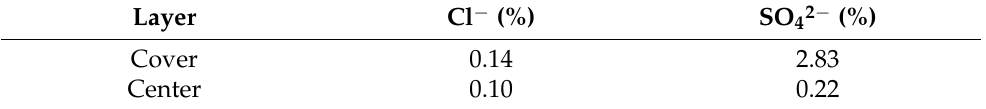
Table 7. Mean content of chloride ions and sulfate ions in concrete as a percentage of mass of